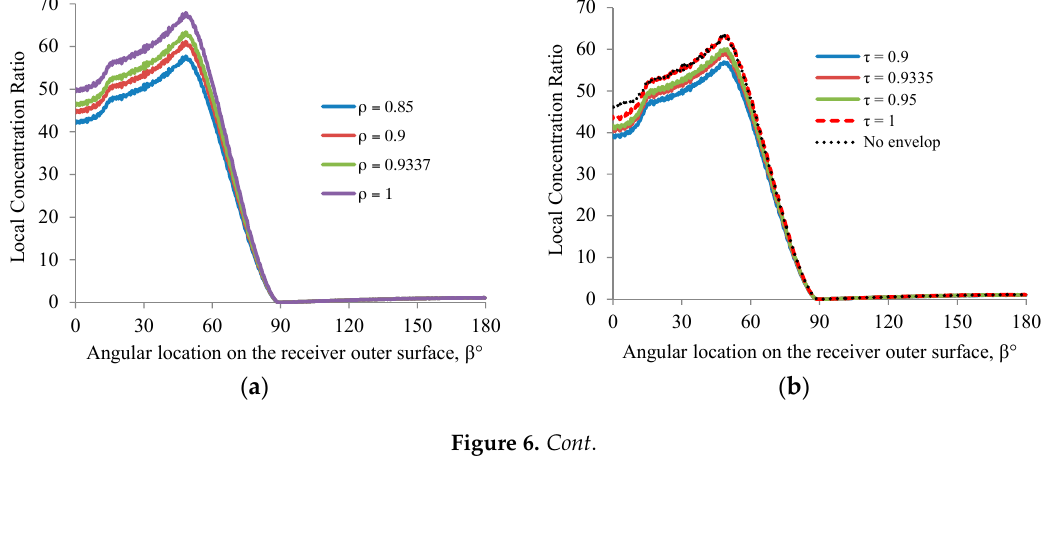
( f ) Figure 6. Effect of ( a ) mirror reflectance; ( b ) glass transmittance; ( c ) receiver absorptance; ( d ) DNI and ( e ) glass thickness on the LCR distribution around the receiver tube, and ( f ) effect of these parameters on the normalised optical efficiency, η opt , and normalised average light concentration, C avg , of the collector. (These values were normalised dividing by their respective maxumum value). 4.2. Effect of Design Parameters of the Collector Focal length, rim angle and GC are three fundamental design parameters of a PTC. Focal length is the characteristic parameter of a parabolic mirror. The depth and width of the mirror depend directly on the rim angle. On the other hand, GC is the ratio of the mirror aperture area to the receiver surface area. The GC of a PTC can be varied either by varying the receiver diameter or mirror width independently or both together. However, variation of the mirror width causes variation of the rim angle. The effects of rim angle and GC on the optical performance of a PTC were investigated with a mirror of fixed focal length, and with mirrors of different focal lengths as described